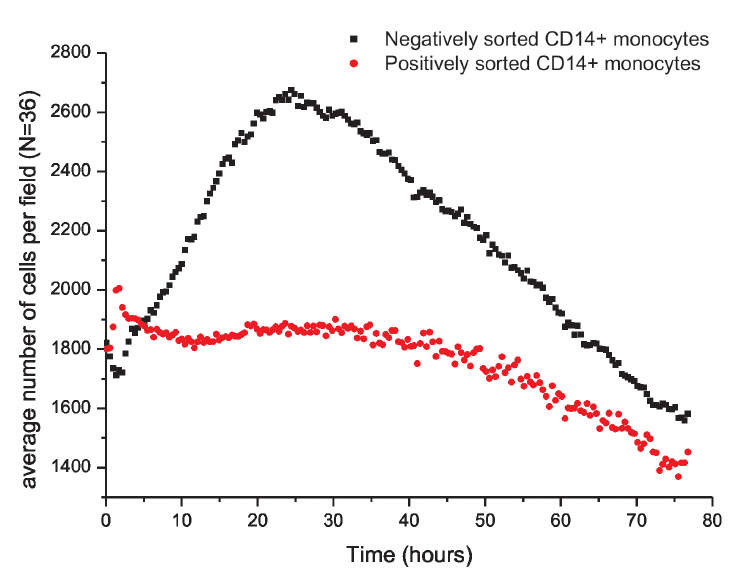
Figure 2. The changes in the average number of cells per field (487μmX364μm) over time, upon stimulation by LPS in positively and negatively sorted cells.